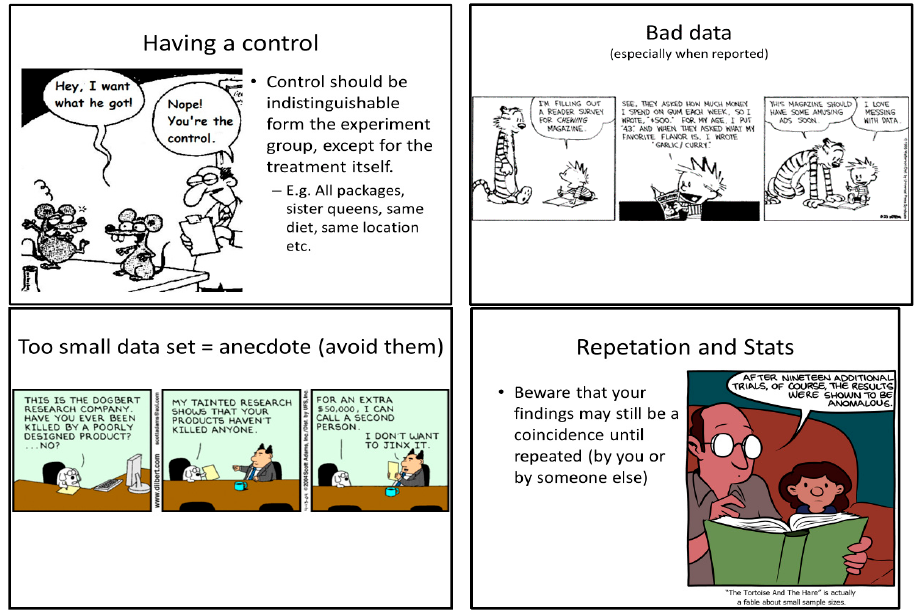
Figure 2. Four cartoons used as presentation slides in Science 101 for Beekeepers. Each cartoon represents a separate slide, which we have combined for presentation purposes.